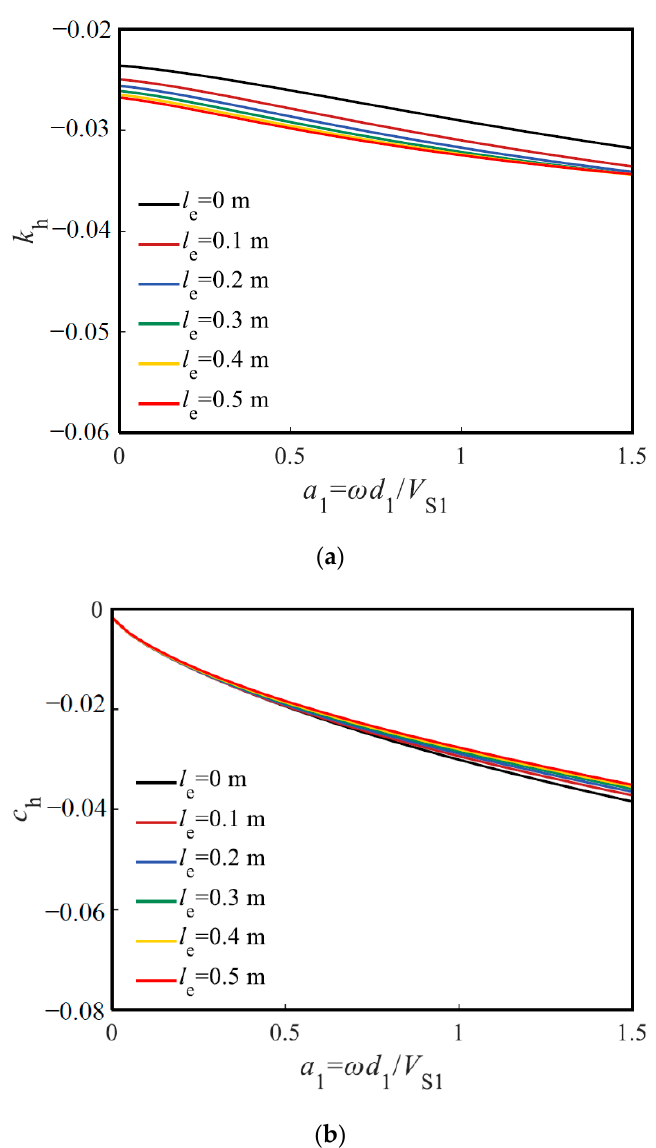
Figure 7. Influence of weak pile segment length on the HDI of pile head. ( a ) Stiffness factor of HDI and ( b ) damping factor of HDI.